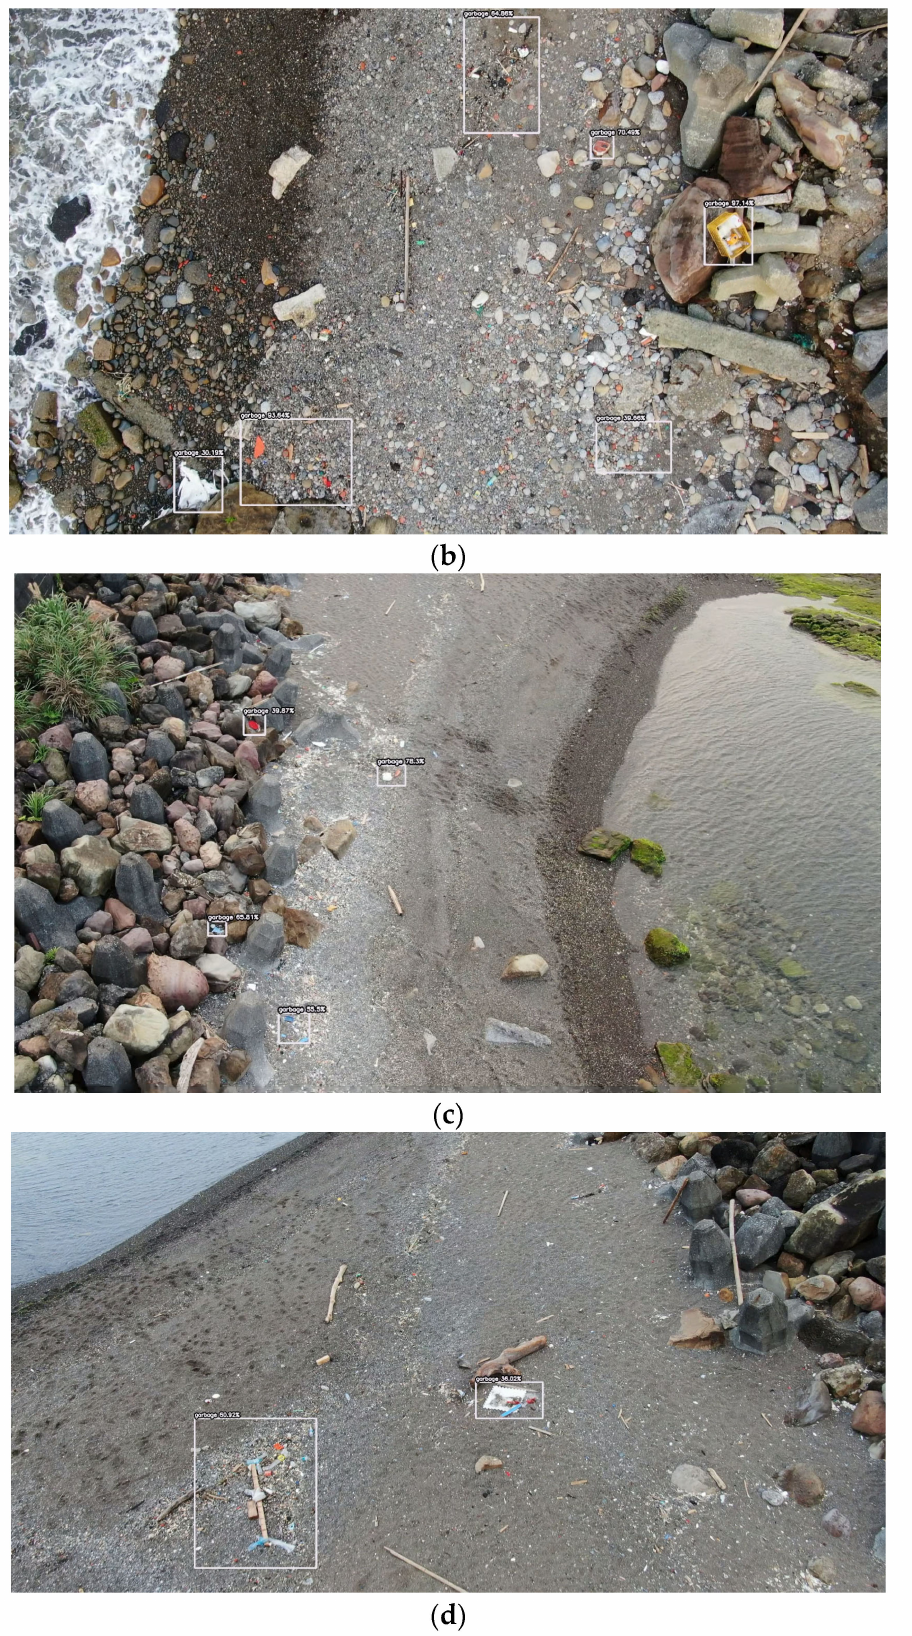
Figure 18. The detection results in the HAIDA-2 trash dataset by YOLOv4-Tiny-3l